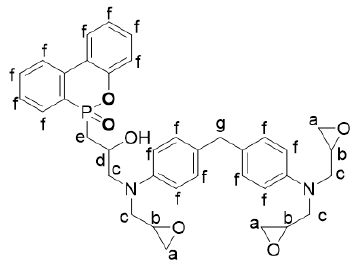
Figure 10. MBDA-DOPO structure.